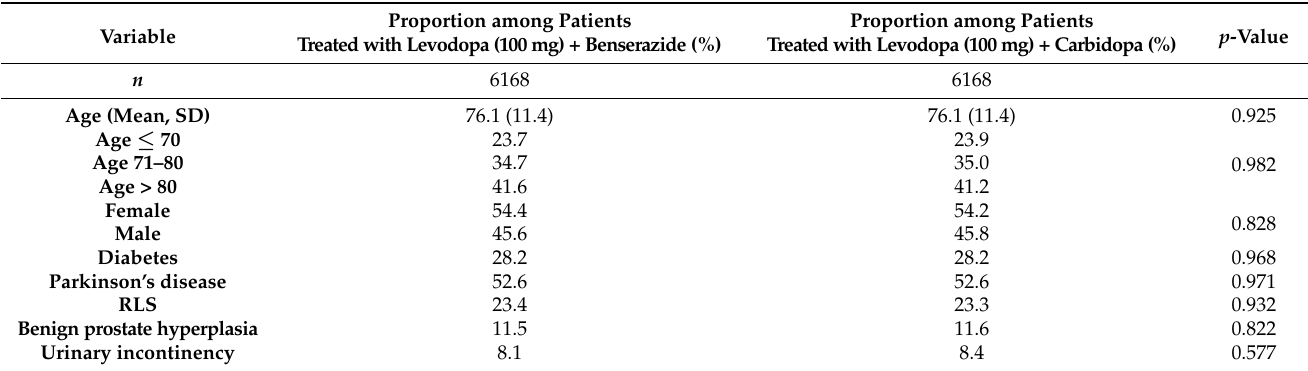
Figure 1. Selection of study patients. Table 1. Basic characteristics of the study sample after propensity score matching.